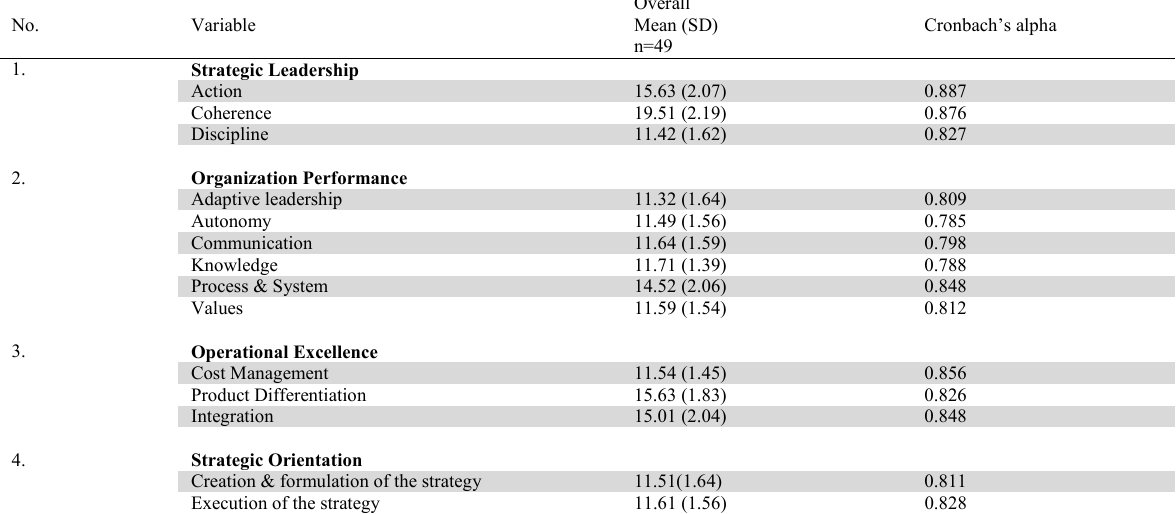
Descriptive statistic: the mean scores and Cronbach’s alpha of the constructs N= 49